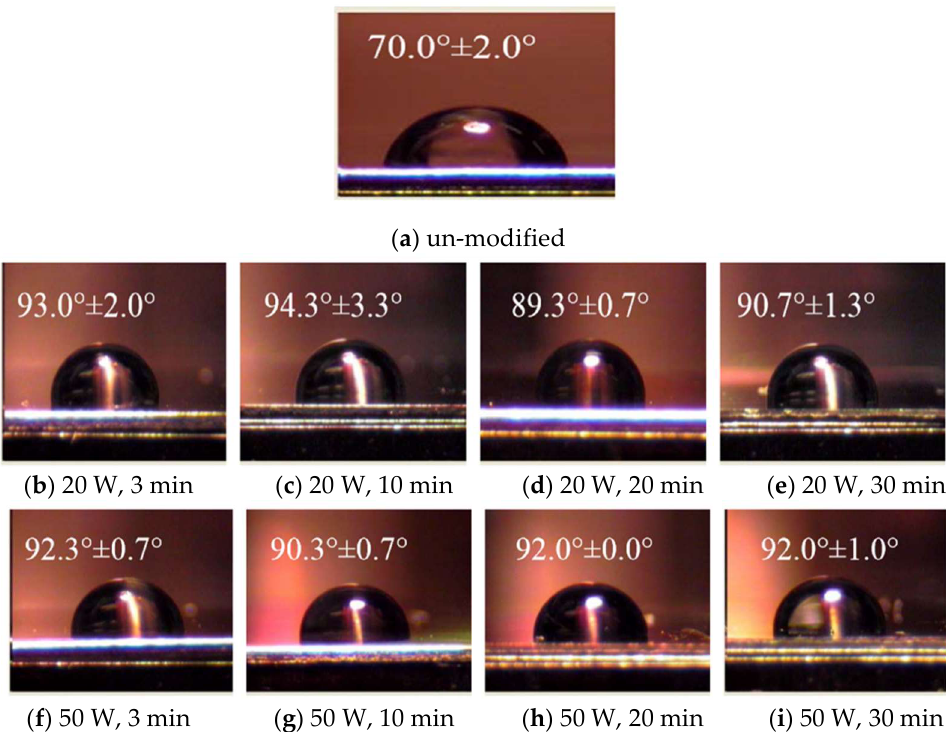
Figure 6. The water contact angle of HMDSZ plasma deposited (PD-HMDSZ) stainless steel (PD-HMDSZ: 60 mTorr). ( a ) un-modified, ( b ) 20 W, 3 min, ( c ) 20 W, 10 min, ( d ) 20 W, 20 min, ( e ) 20 W, 3 min, ( f ) 50 W, 3 min, ( g ) 50 W, 10 min, ( h ) 50 W, 20 min and ( i ) 50 W, 3